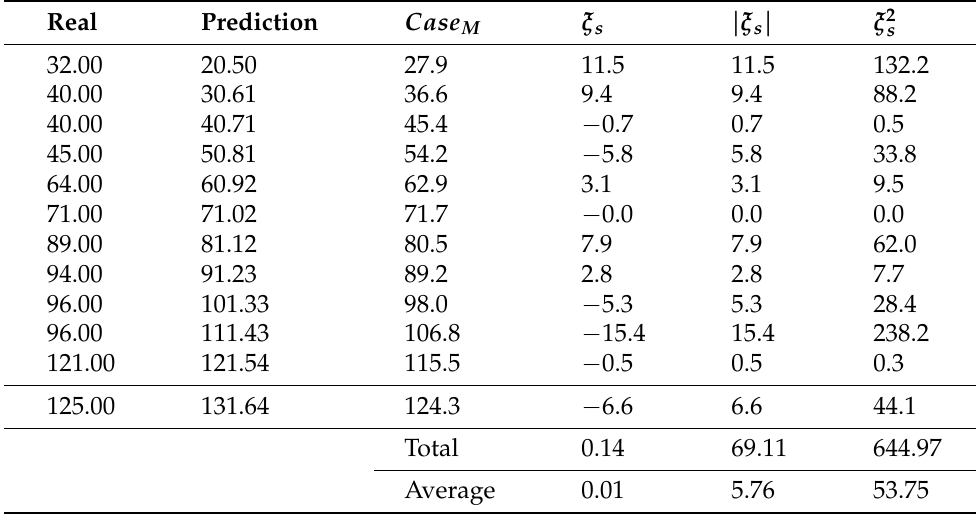
Table 3. Details and error study.